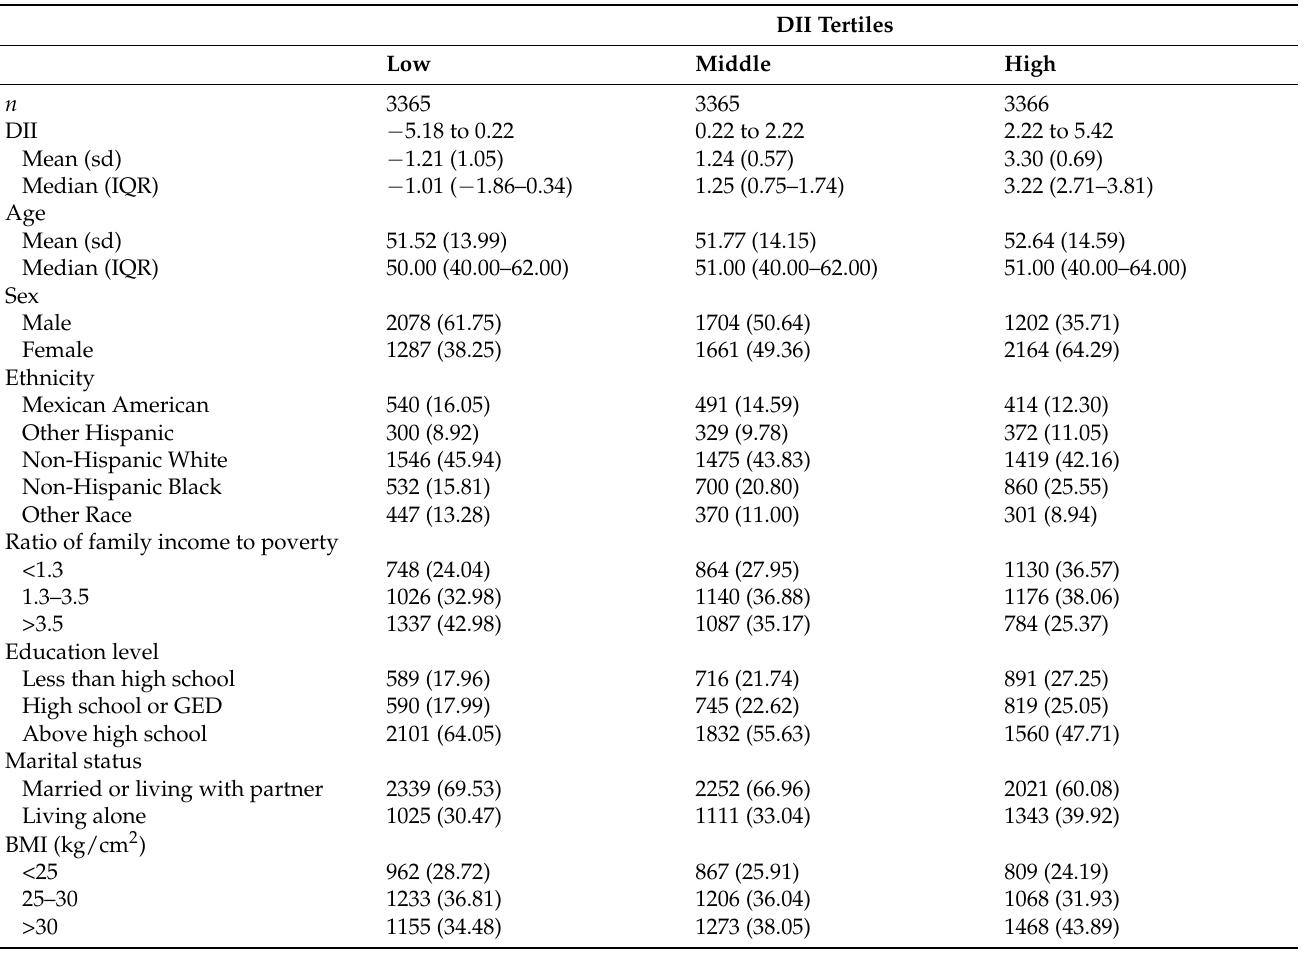
Table 1. Characteristics of participants (NHANES 2009–2014, N = 10,096). DII Tertiles Low Middle